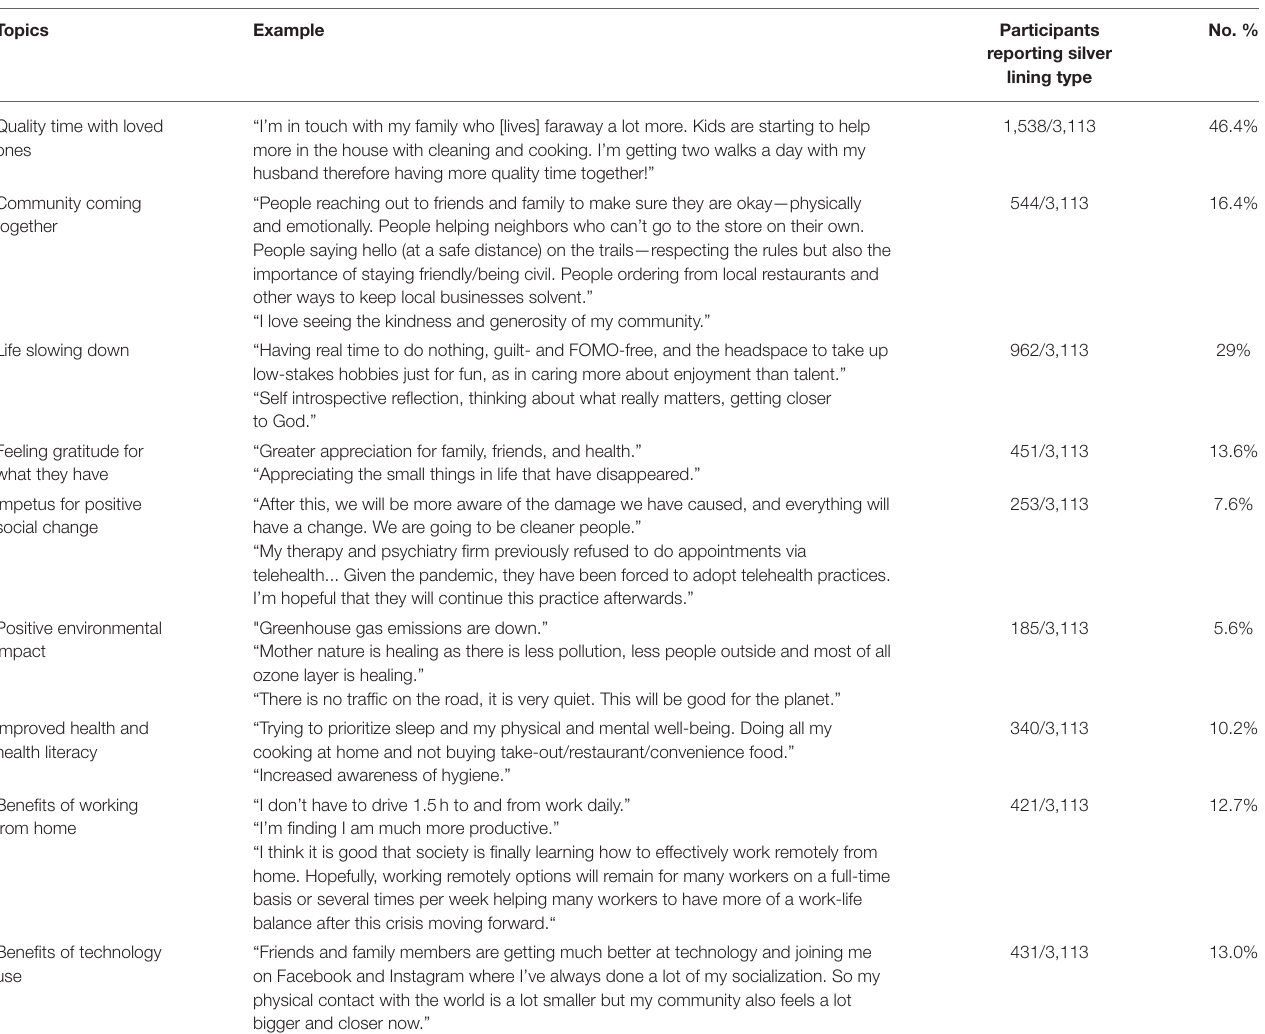
TABLE 2 | COVID-19 silver lining identified from manual content